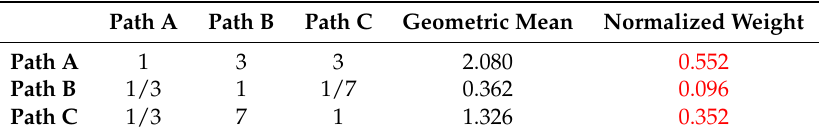
Table 3. Weight Evaluation for ‘Safety’.